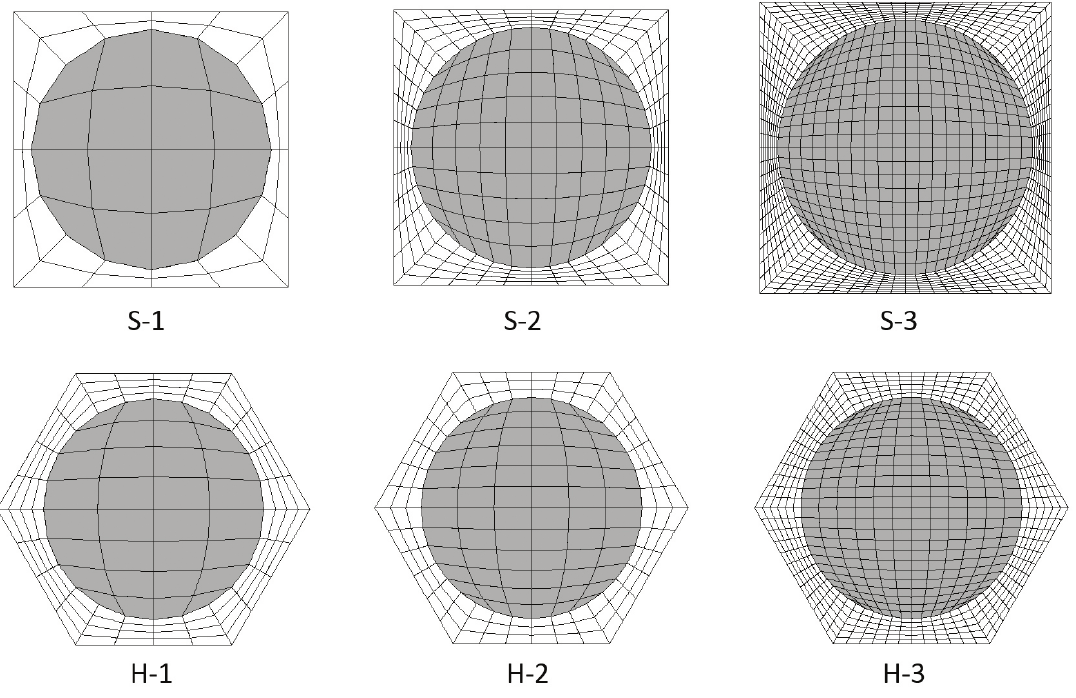
Figure 6. RUC discretizations for square and hexagonal arrays.